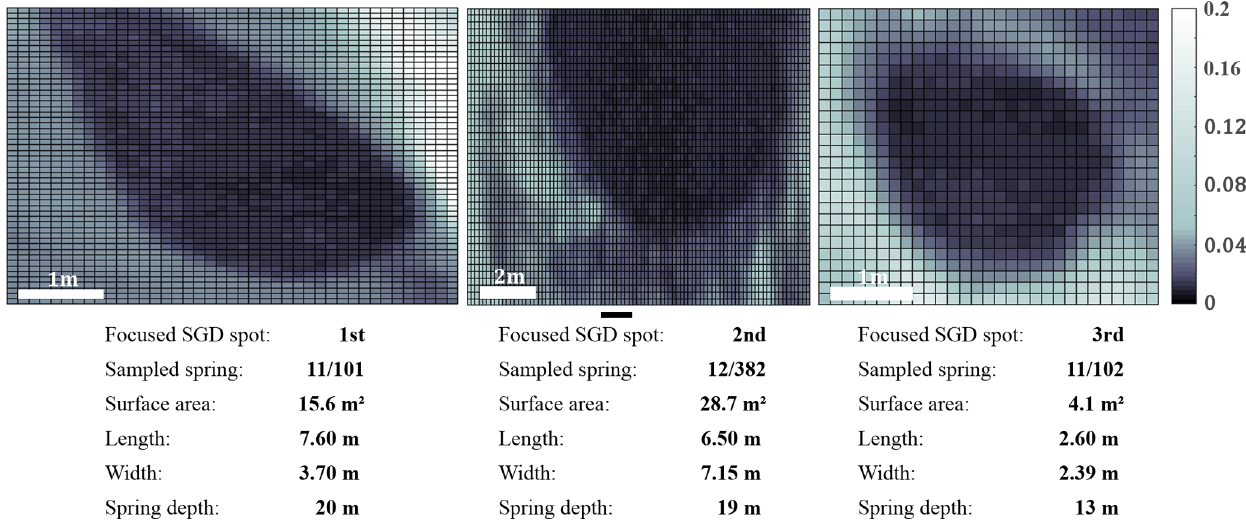
Figure 4. Spatial characteristics of the presented focused SGD spots and their spatial correspondence of sampled submarine springs during previous campaigns. Table 1. Summary of values characterizing the spatio-temporal behaviour of each focused and diffuse SGD spot. SGD Corresponds Spatial Peak values b Significant Significant spot to sampled variation a (standard deviation) periodicity period spring (in %) (in